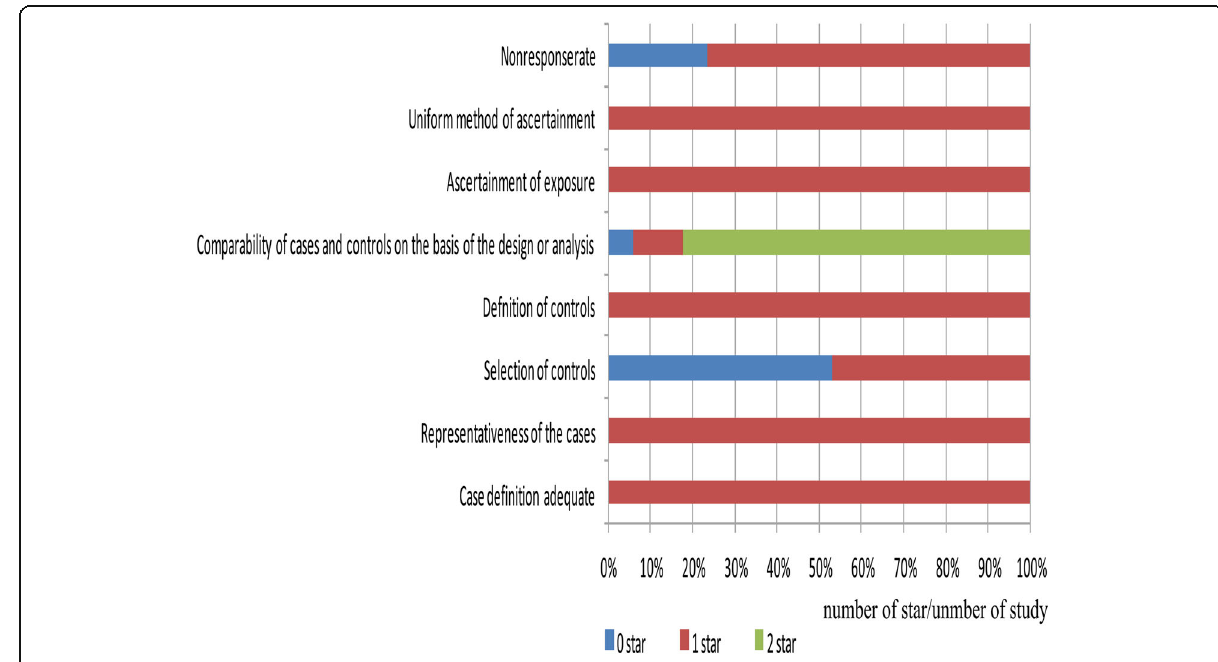
Fig. 2 Graph of quality assessments